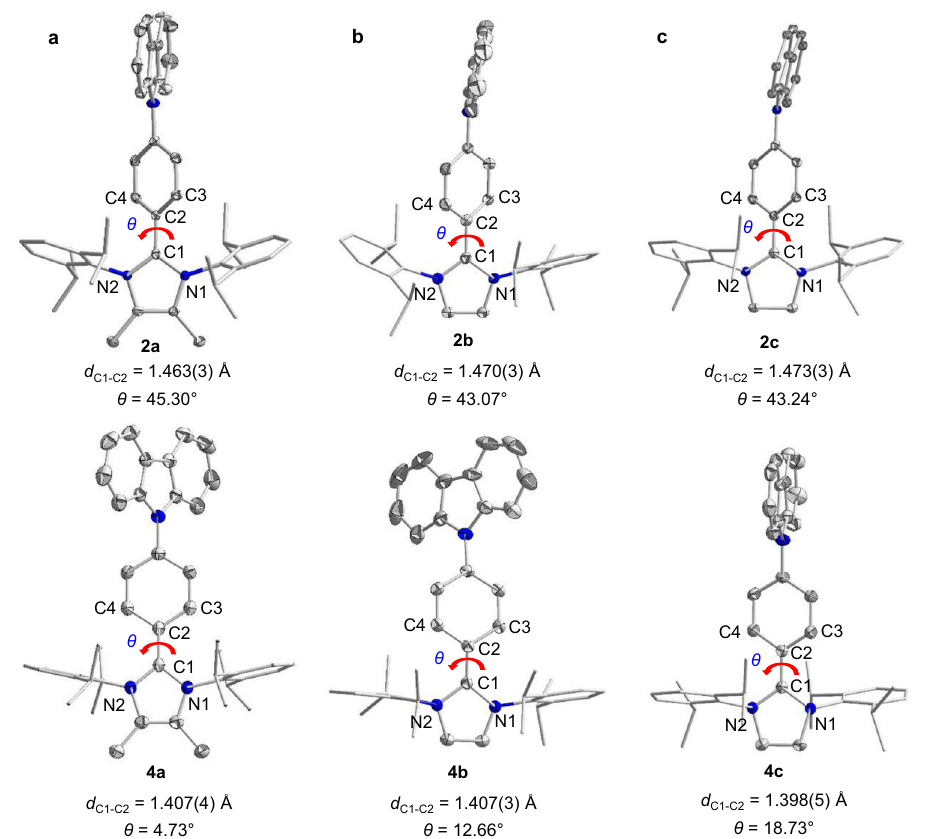
Fig. 3 | X-ray solid-state structures of the CBP – NHC precursors and their cor- respondingcarbon-centeredradicals.a X-raysolid-statestructuresforprecursor 2a and radical 4a . b X-ray solid-state structures for precursor 2b and radical 4b . c X-ray solid-state structures for precursor 2c and radical 4c . θ : the twisted angle between the C3 – C2 – C4 and N1 – C1 – N2 plane. The single crystals of radical pre- cursors 2a – c were grown by slowly diffusing diethyl ether into a saturated acet- onitrilesolutionatambienttemperature.Thesinglecrystalsofradicals 4a – c canbe obtained from a saturated hexane solution after cooling to − 30°C.